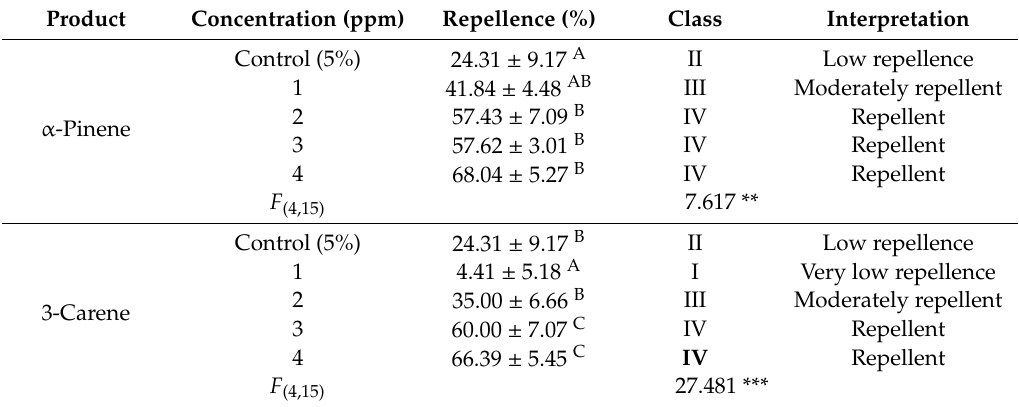
Table 4. Repellence of Sitophilus zeamais due to treatment of stored maize with α -pinene, 3-carene and Poudrox ®